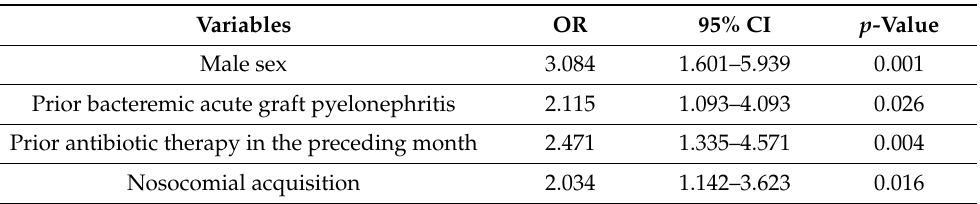
Table 4. Multivariate analysis of risk factors for MDR Gram-negative bacilli acute graft pyelonephritis with bacteremia in KT